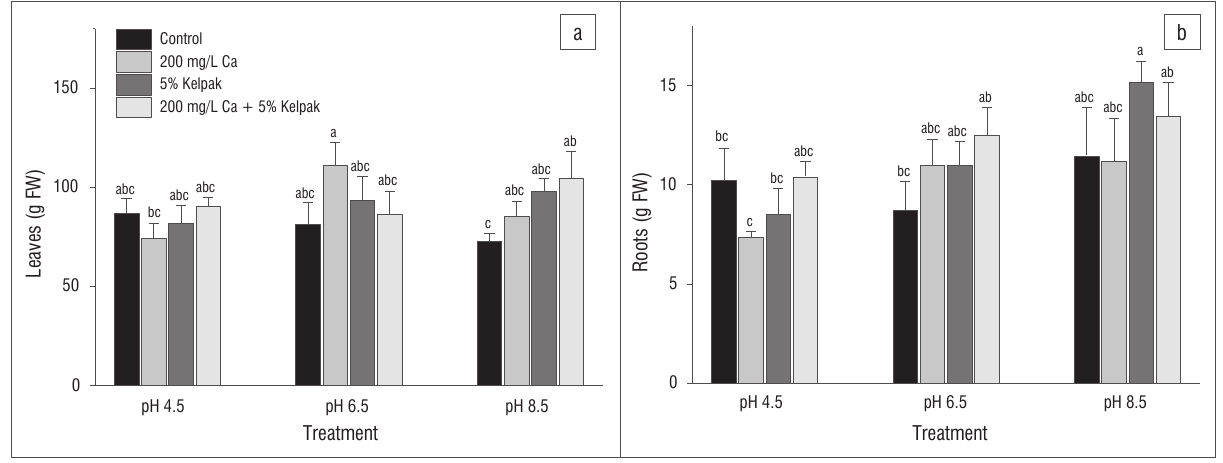
Figure 3: Effect of pH, water hardness (Ca 2+ concentration) and 5% Kelpak on (a) leaf and (b) root (fresh weight) of Swiss chard grown in pots. Letters above bars indicate significant differences (mean±SE where n =6; p <0.05) obtained when data was analysed using Duncan’s Multiple Range